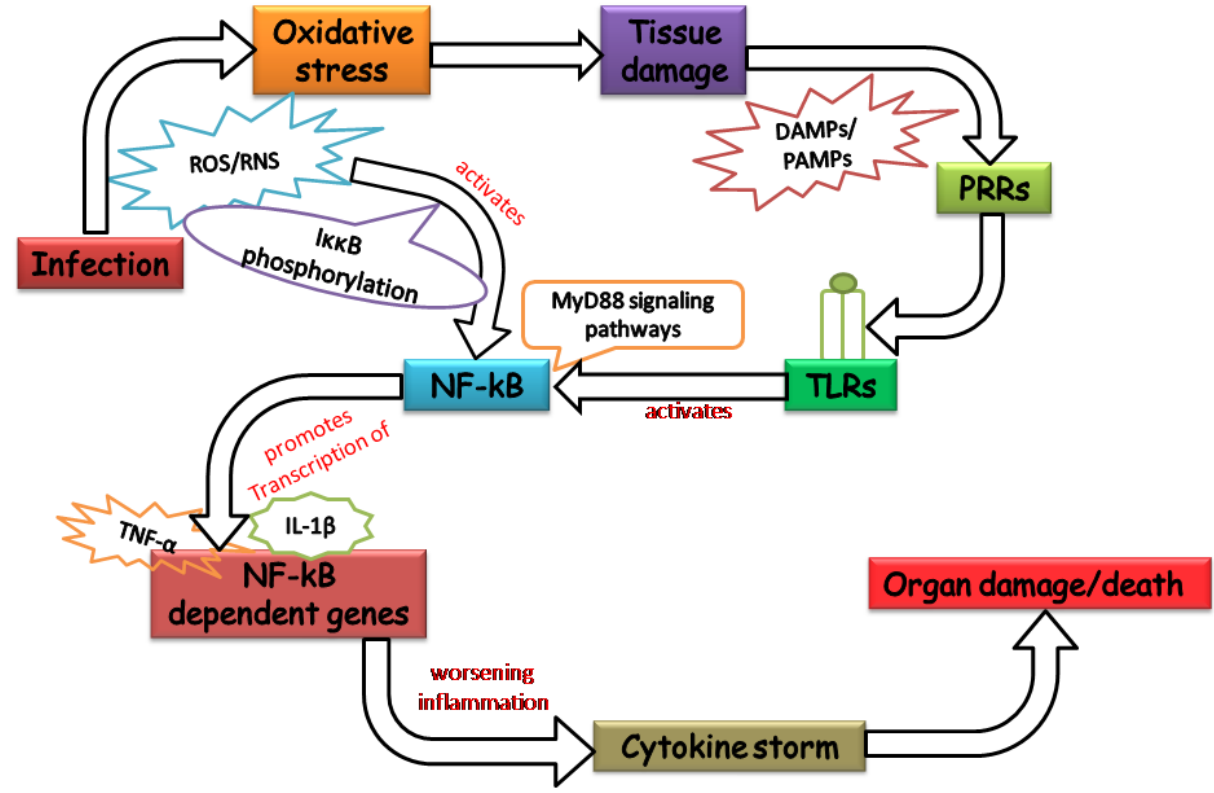
Figure 2. The mechanism by which the organ-damaging pathophysiology of sepsis is exacerbated by oxidants.